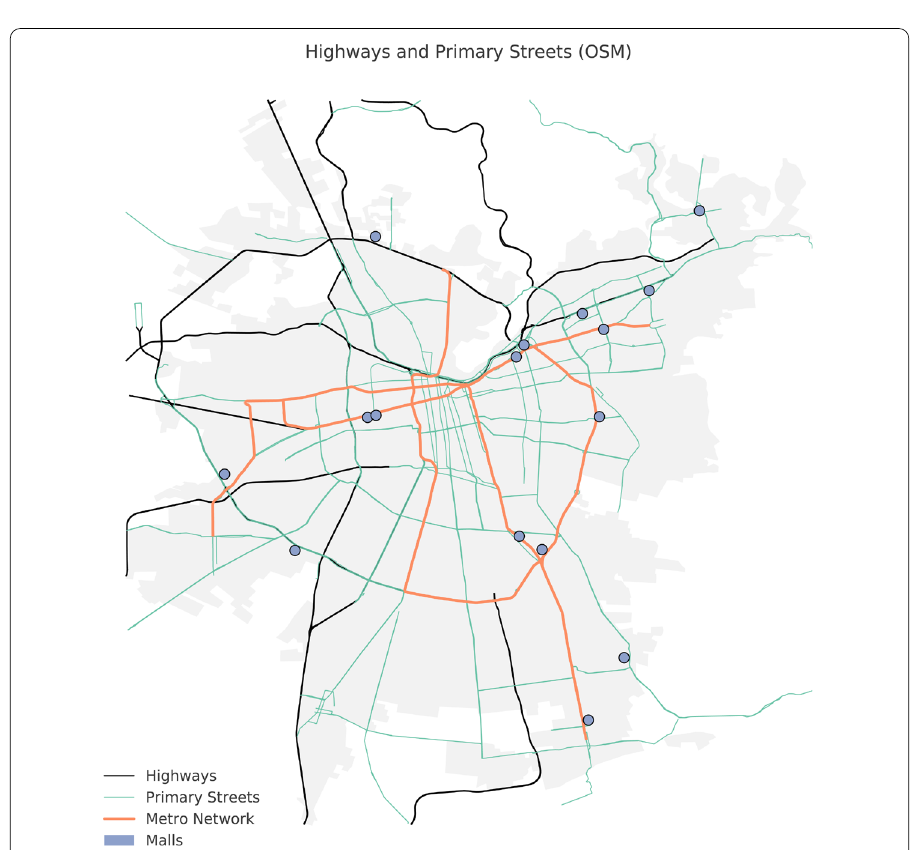
Figure 1 Schematic map of Santiago, urban area. Lines encode highways (black), primary streets (green), the Metro network (orange). Markers are the malls under study. The urban network data is from OpenStreetMap